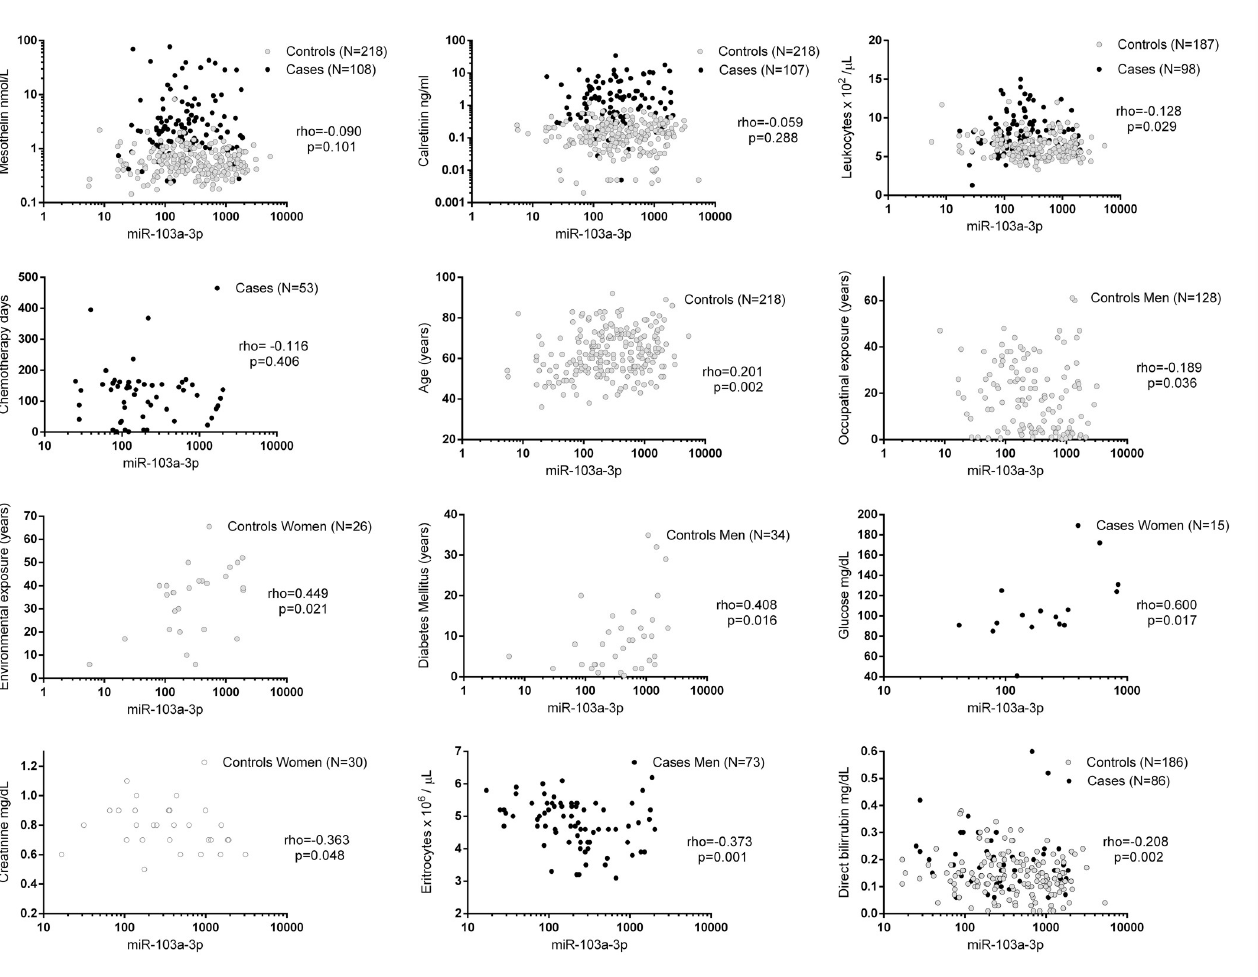
Fig 3. Correlation of miR-103a-3p with different variables in malignant pleural mesothelioma cases and population controls in a Mexican population.